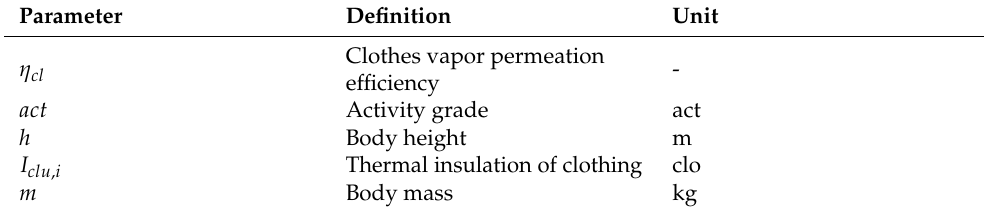
Body mass kg Table 4. Climatic parameters for the employed two-nodes thermal comfort model. Parameter Definition Unit RH Relative humidity of